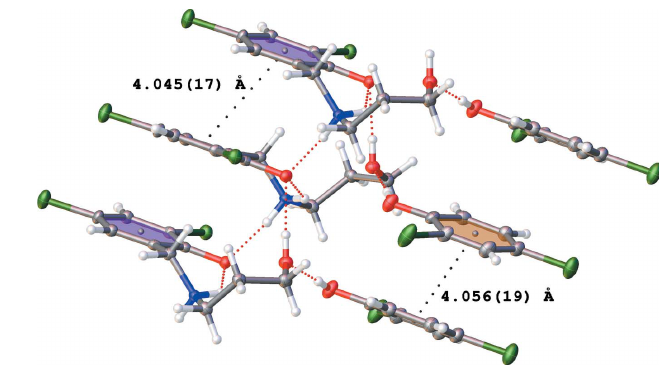
Figure 5 Partial packing arrangement of the title compound showing the (cid:2) – (cid:2) interaction between the 2,4-dichlorophenol hydrophobic layers.